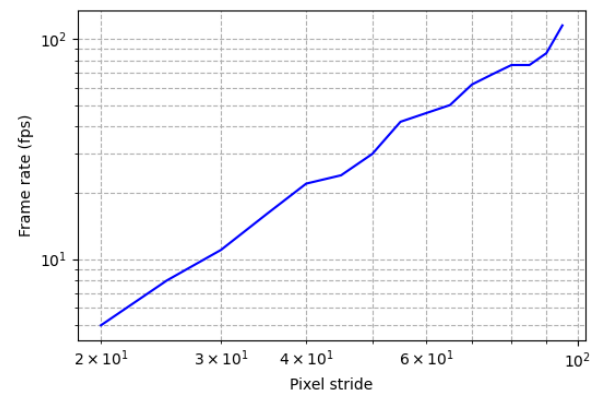
Figure 16. The relation between pixel stride and frame rate. Table 4. HOG-SVM IP-core